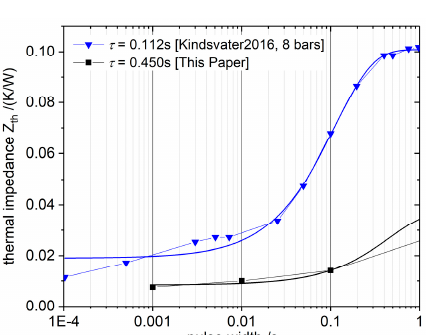
Figure 4. Dynamic thermal impedance for a commercially available pump module for various pulse conditions and the FBH stack module both measured at 10% duty cycle. For the FBH design, the data point outside the graph is for cw operation. Time constants τ is taken from a fit function